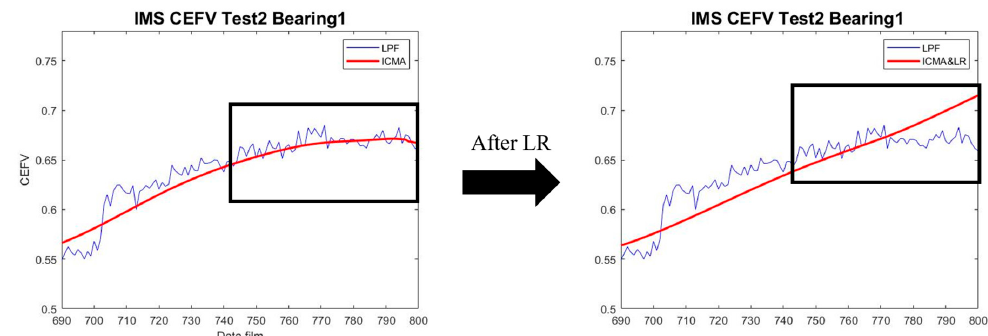
Figure 8. The HI results after LR.